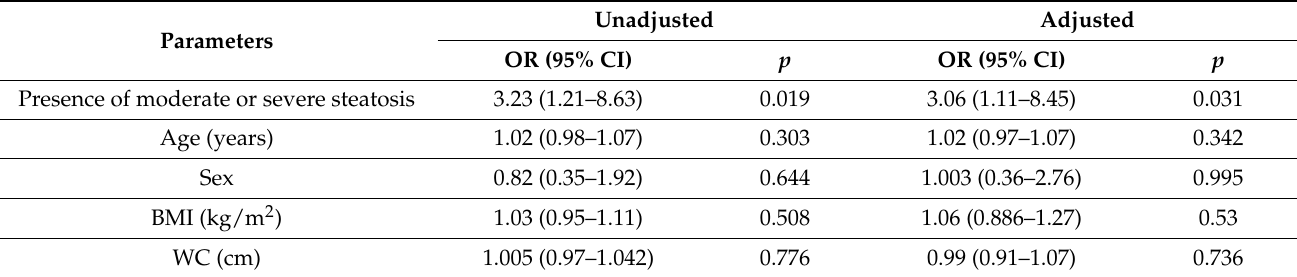
Table 3. Correlations between CIMT and hepatic